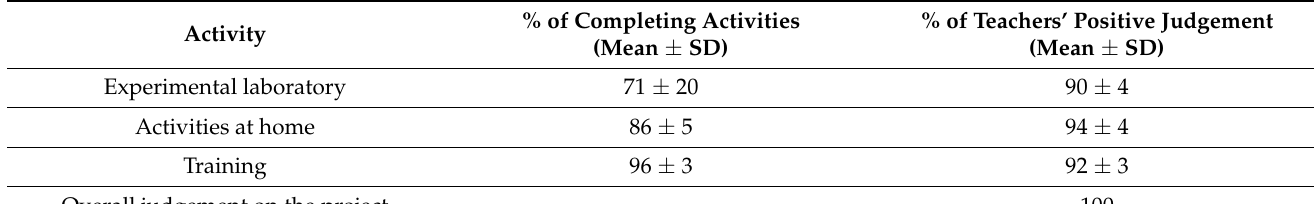
Table 3. Percentage of completing activities and teachers’ satisfaction for the proposed activities.